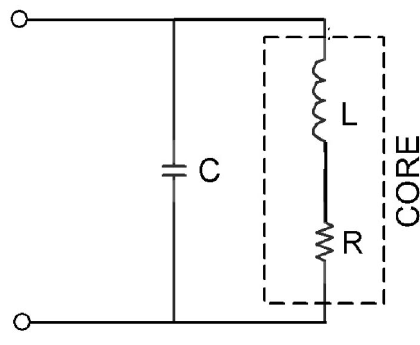
FIG. 1. A circuit diagram of a resonant cavity. A MA core is represented by R and L . The gap capacitance C is connected across the core.